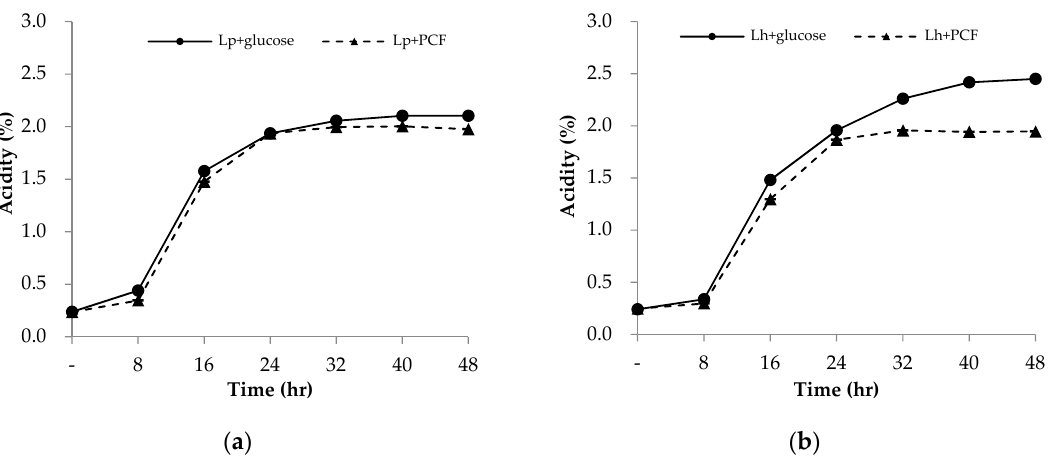
Figure 2. Changes in acidity of Lp ( a ) and Lh ( b ) with glucose or CFE. Values are expressed as mean ± SD.